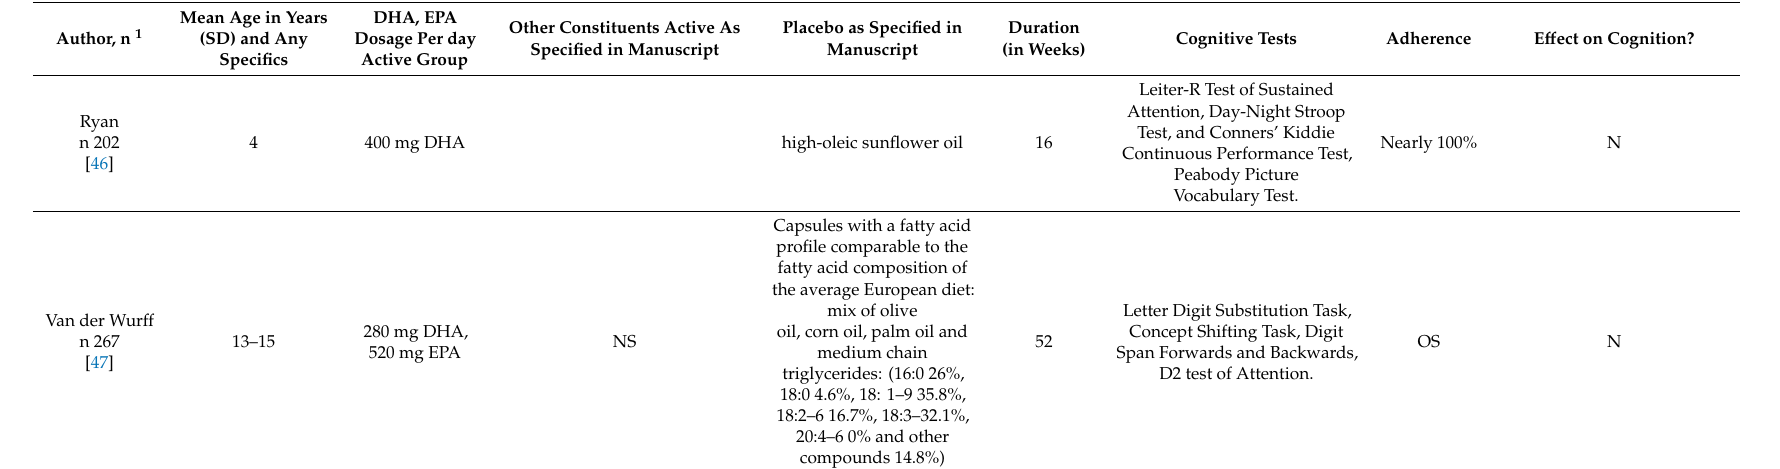
Letter Digit Substitution Task, Concept Shifting Task,